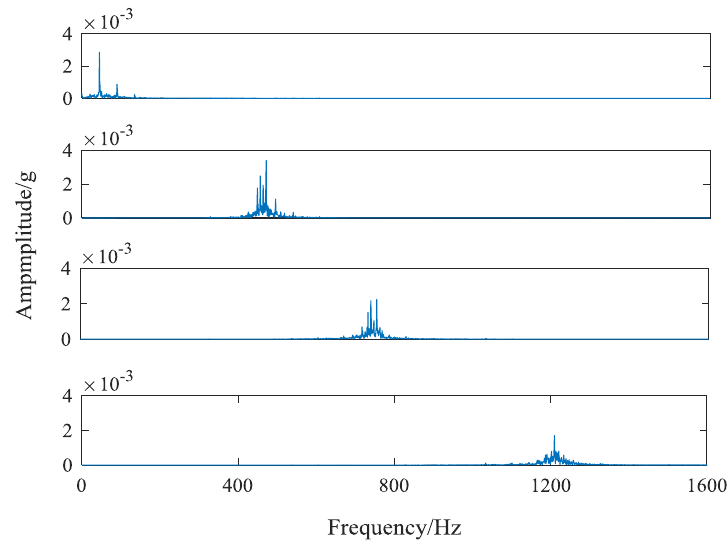
Figure 8. The feature frequency bands extraction based on component frequency spectrum.